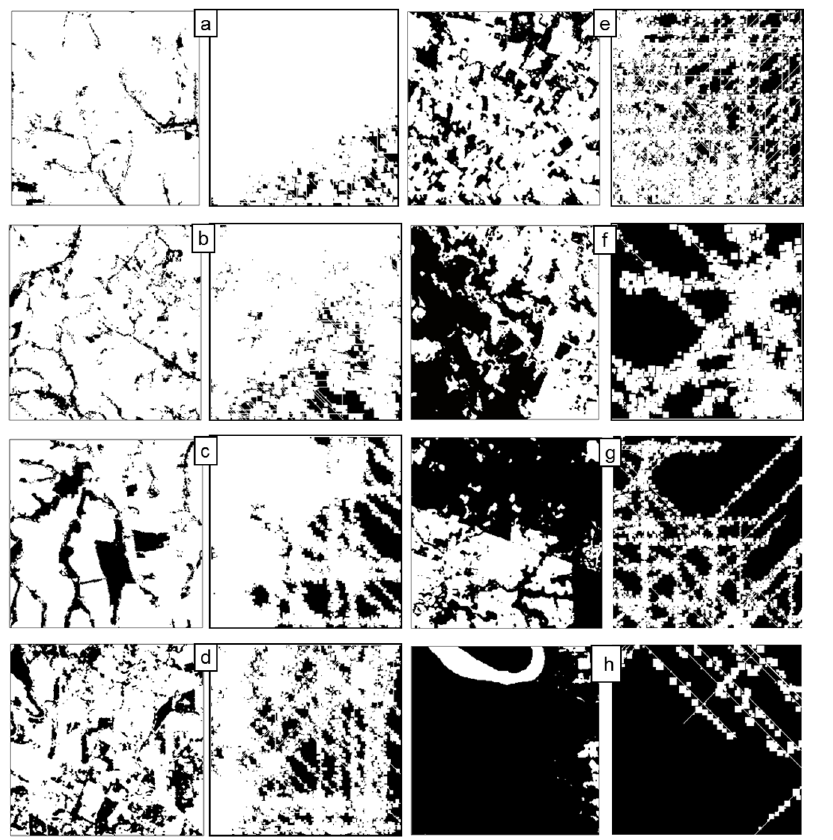
Figure 8. Examples of eight real landscape maps compared to corresponding landscapes generated by G-RaFFe . Depicted maps have a forest cover of 5, 10, 19, 26, 27, 51, 65, and 90%. Each landscape is compared to a corresponding landscape map generated by G-RaFFe with the parameters that were identified to provide the best match. Figure 8e (27% FC) was matched by G-RaFFe for only 5 metrics, and 3 for the other models; d,e,g,h were poorly matched by Qrule ( , 5 metrics matched), while Simmap failed for maps a,b,e,f (matching=0) and g. For maps d,g, and h Simmap performed better than Qrule . For the parameters of the real and virtual landscapes see Appendix S2.